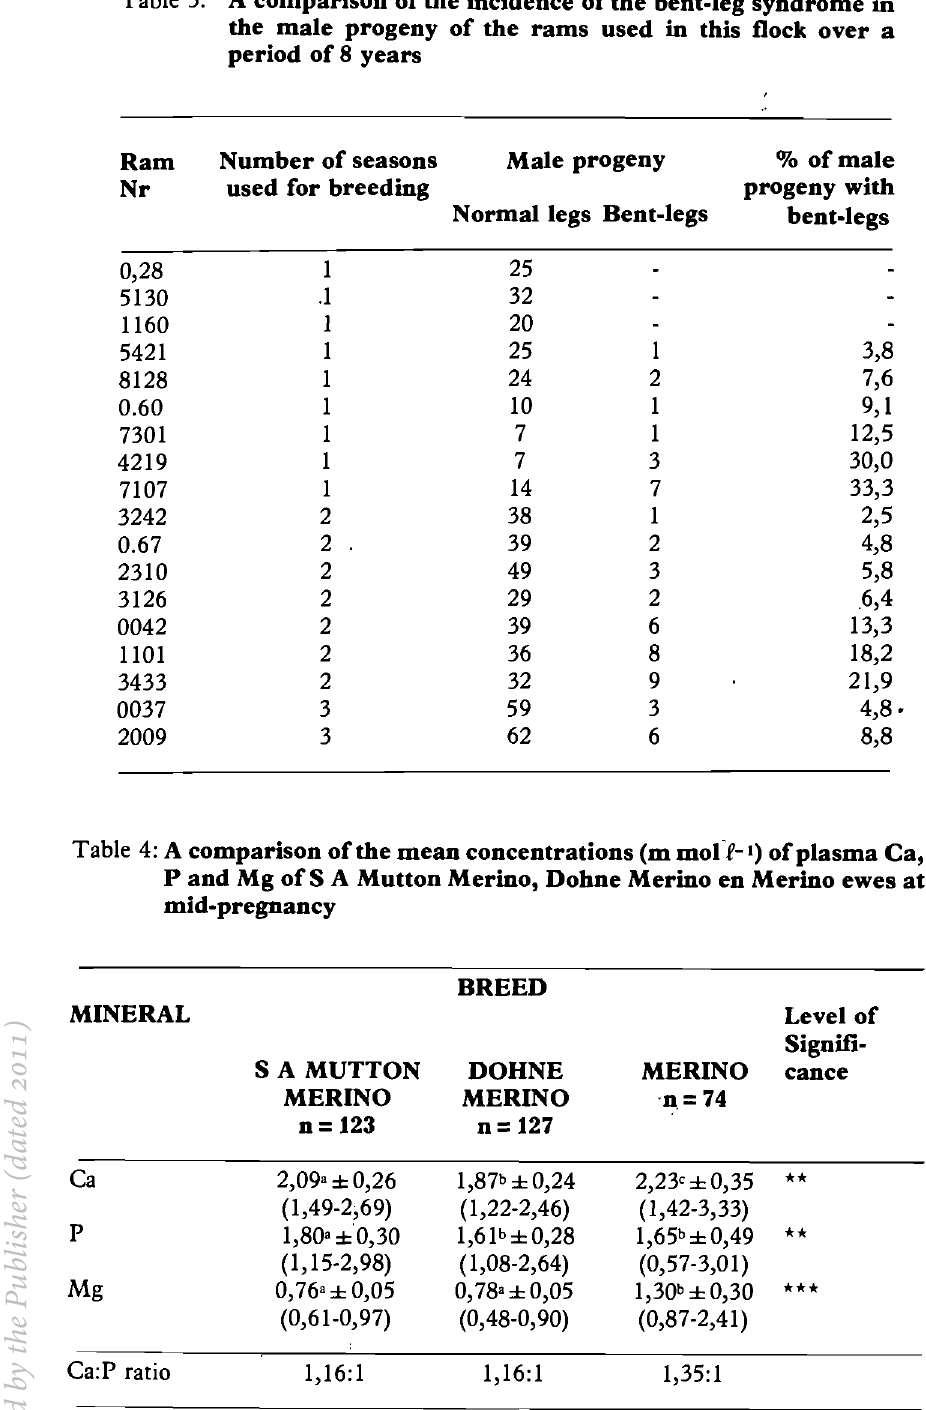
still withi~ normal ranges (1,29-1,94 mmol £-1) for adult sheeplO. Differences in P metabolism between individual sheep, were descibed by Scott & McLean 8• Sheep fed an excess P,